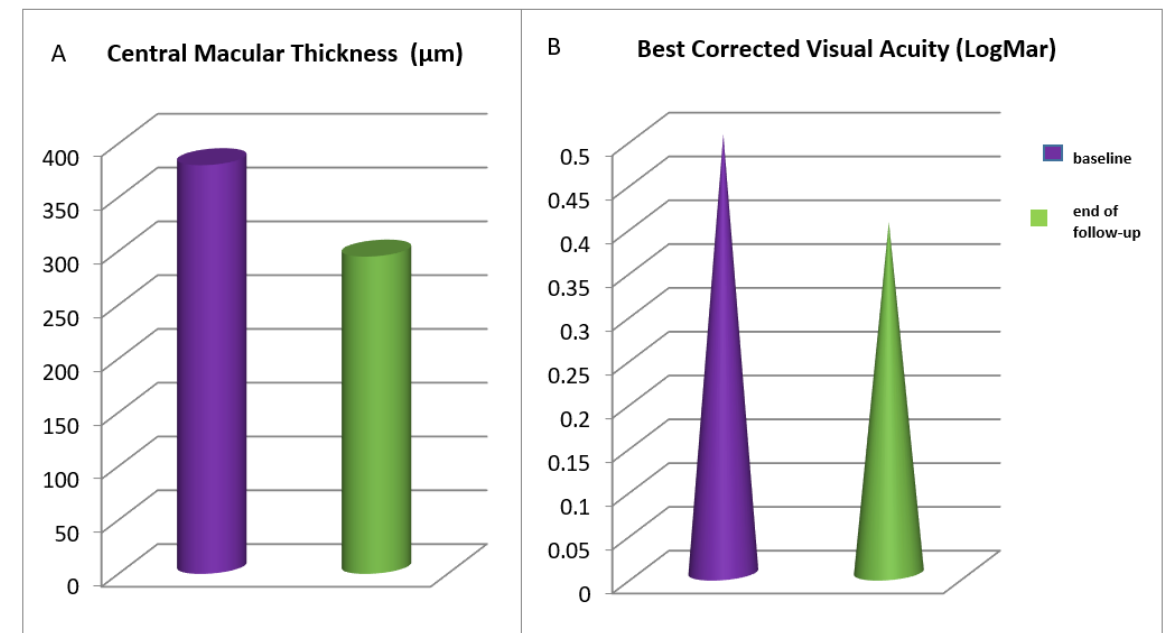
Figure 1. Central macular thickness ( A ) and best corrected visual acuity ( B ) values at baseline and at the end of the follow-up for all patients receiving intravitreal treatment for diabetic macular edema.